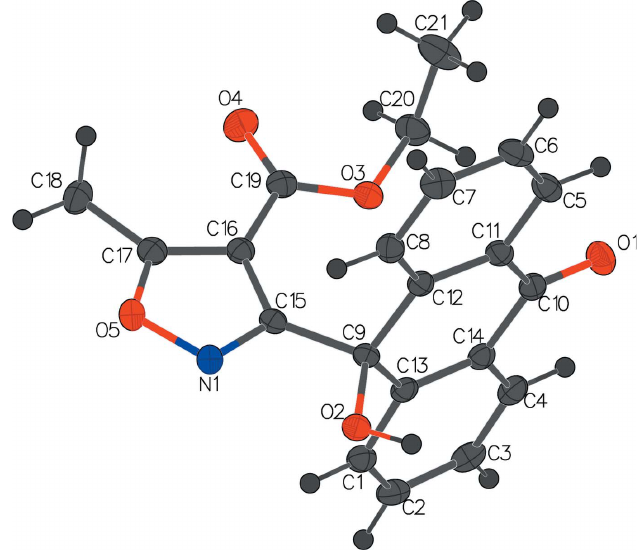
Figure 3 The asymmetric unit of compound (V) with displacement ellipsoids drawn at the 50% probability level.